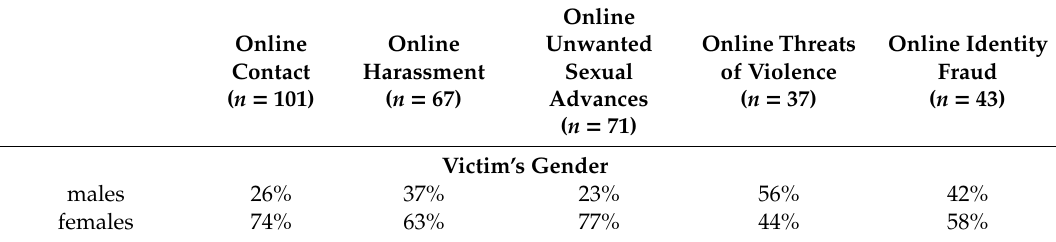
Table 1. The cyberstalking